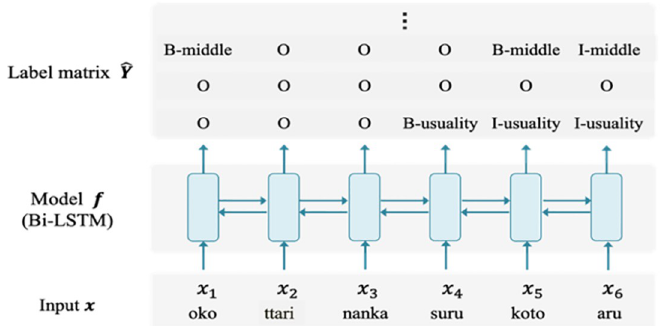
Fig 6. IOB2 notation—Schematic diagram of the tagging prediction process by Bi-LSTM. “ Oko ttari nanka suru koto aru (There are occasions when I get mad)”. Middle denotes a type of verb form with a perspective lacking agency. Usuality is a type of modality expressing how often an event tends to occur. Further explanation is provided in Table 4. Both are selective resources embedded in the system